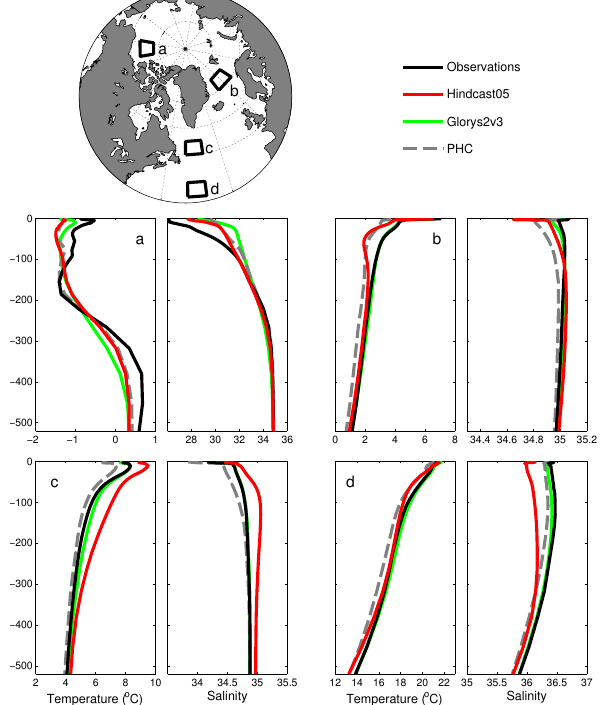
Figure 7. Average temperature and salinity profiles within the boxes shown in the top panel. All available observations within each box during the period 2003–2009 are averaged and plotted. Correspond- ing profiles from hindcast H05, the GLORYS2v3 ocean reanalysis and the Polar Science Center Hydrographic Climatology (PHC), calculated in each case by averaging profiles at the same times and locations as the observations, are also shown. The boxes repre- sent (a) the Beaufort Sea (73–78 ◦ N, 152–132 ◦ W), (b) the Green- land and Norwegian seas (70–75 ◦ N, 10 ◦ W–10 ◦ E), (c) the subpo- lar gyre (50–55 ◦ N, 50–40 ◦ W) and (d) the subtropical gyre (35– 40 ◦ N, 49–41 ◦ W). Note the different scaling on the horizontal axis for each panel.